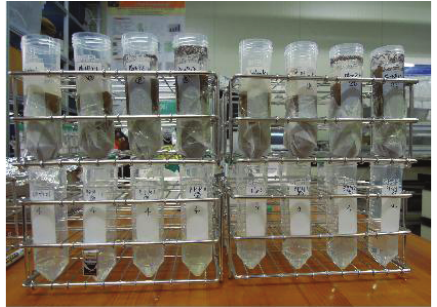
Figure 1: Experimental apparatus of column leaching